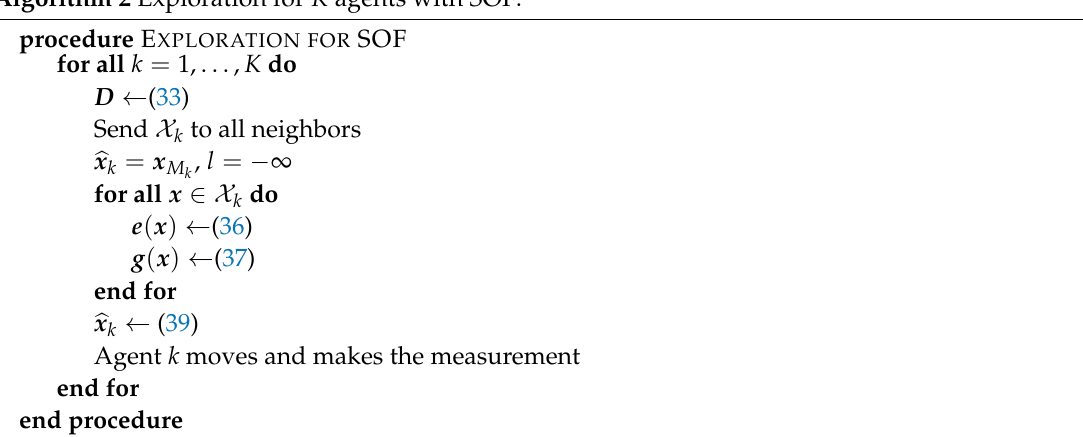
Algorithm 2 Exploration for K agents with